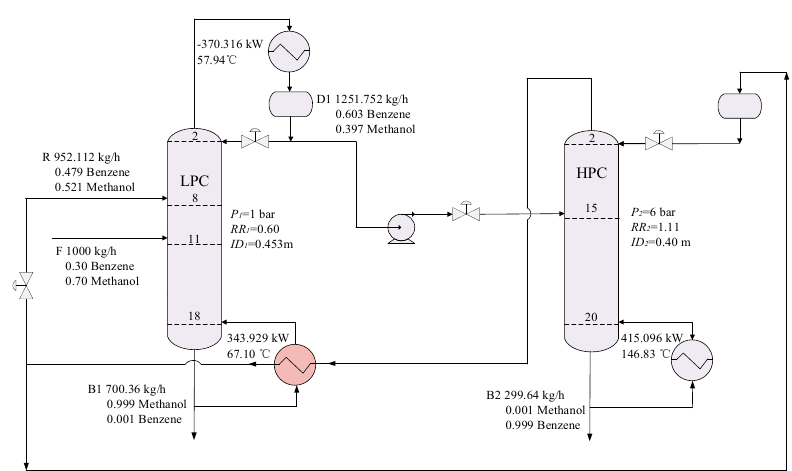
Figure 7. Flowsheet of the best optimal fully HIPSD process.